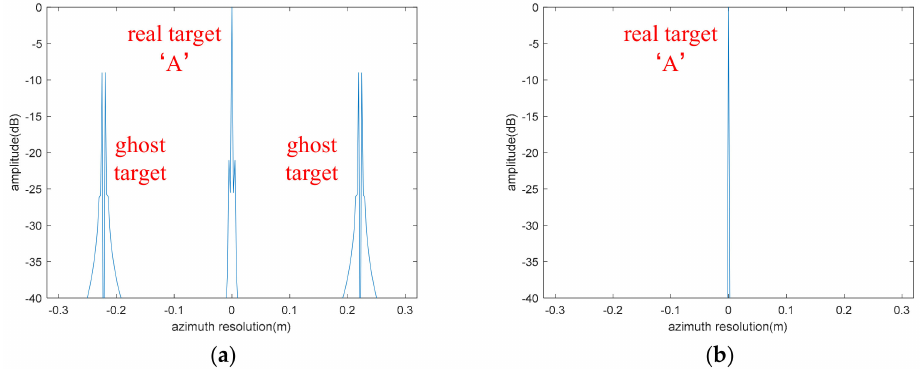
Figure 16. Azimuth profiles of targets in the red dashed boxes in Figure 15. ( a ) Without compensation and ( b ) with compensation.